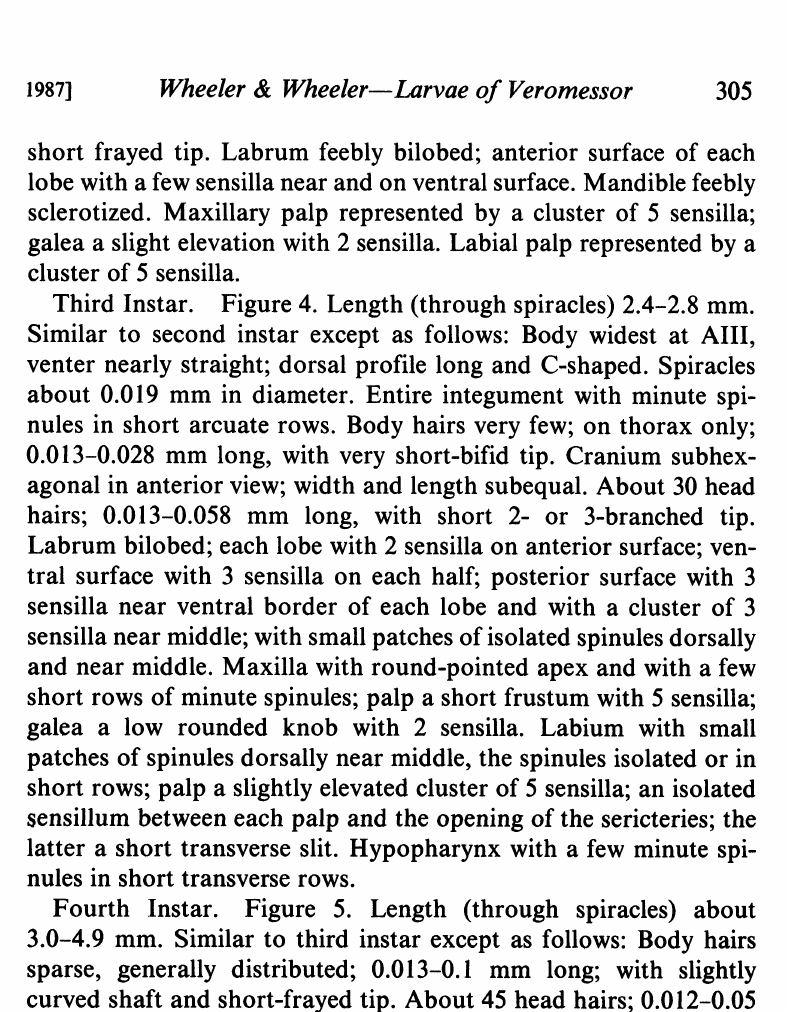
Figure 6. Length (through